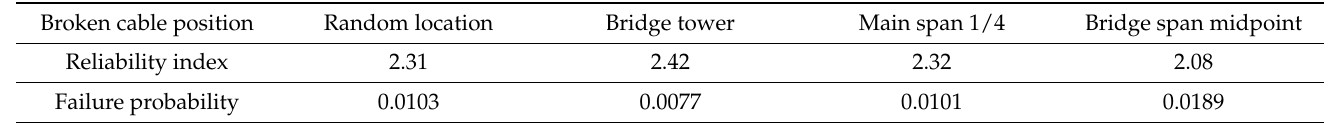
Table 14. Flutter failure probability corresponding to different cable breakage